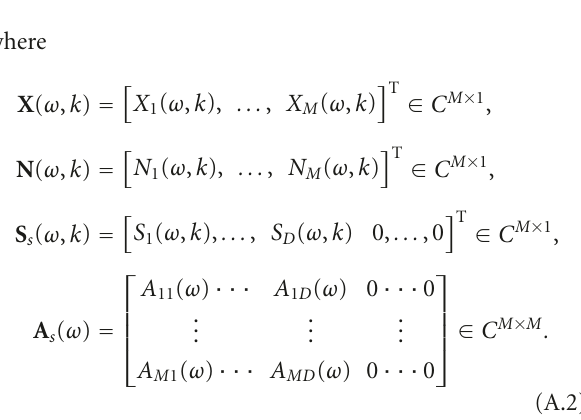
proposed method uses sound velocity as the criterion for time delay candidate selection and the adaptive K-means++ is employed at final stage to cluster the sound source number and directions. The other advantage of the proposed method is that there is no a priori knowledge for sound source number and we use the adaptive K-means++ to estimate the sound source number and directions